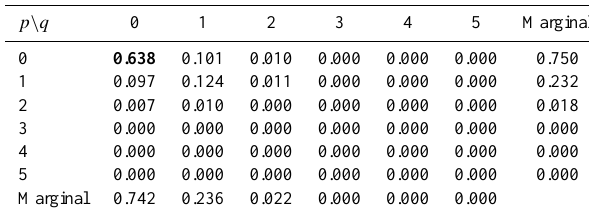
Table 4. Posterior model probabilities for Nile minima time series for the autoregressive parameter p and moving average parameter q . Bold numbers denote the best fit model.